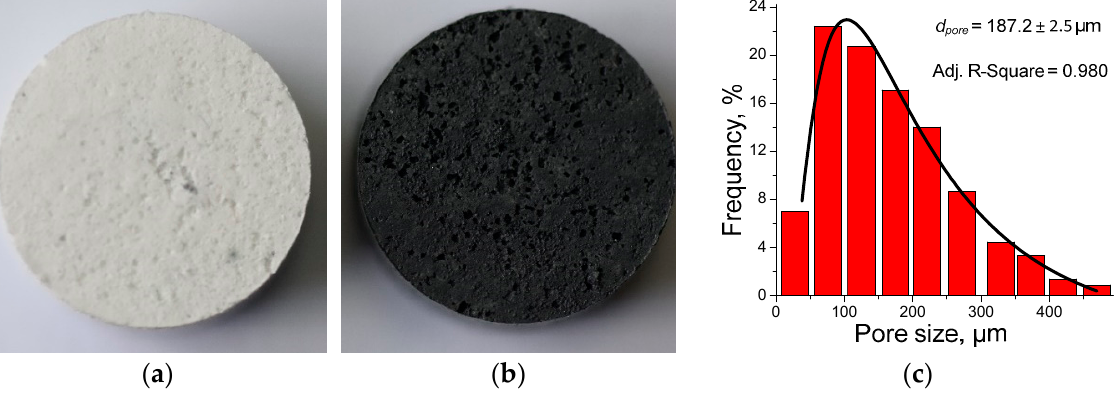
Figure 3. Images of the macroporous ceramic samples before ( а ) and after ( b ) impregnation with Al or Al/Ag nanoparticle suspension and pore size distribution curve ( c ). The disc diameter is 11 mm. The amount of hydrogen released as a result of the aluminum − water interaction was used as an estimate of the amount of fixed nanoparticles on the ceramics (Figure 4). The